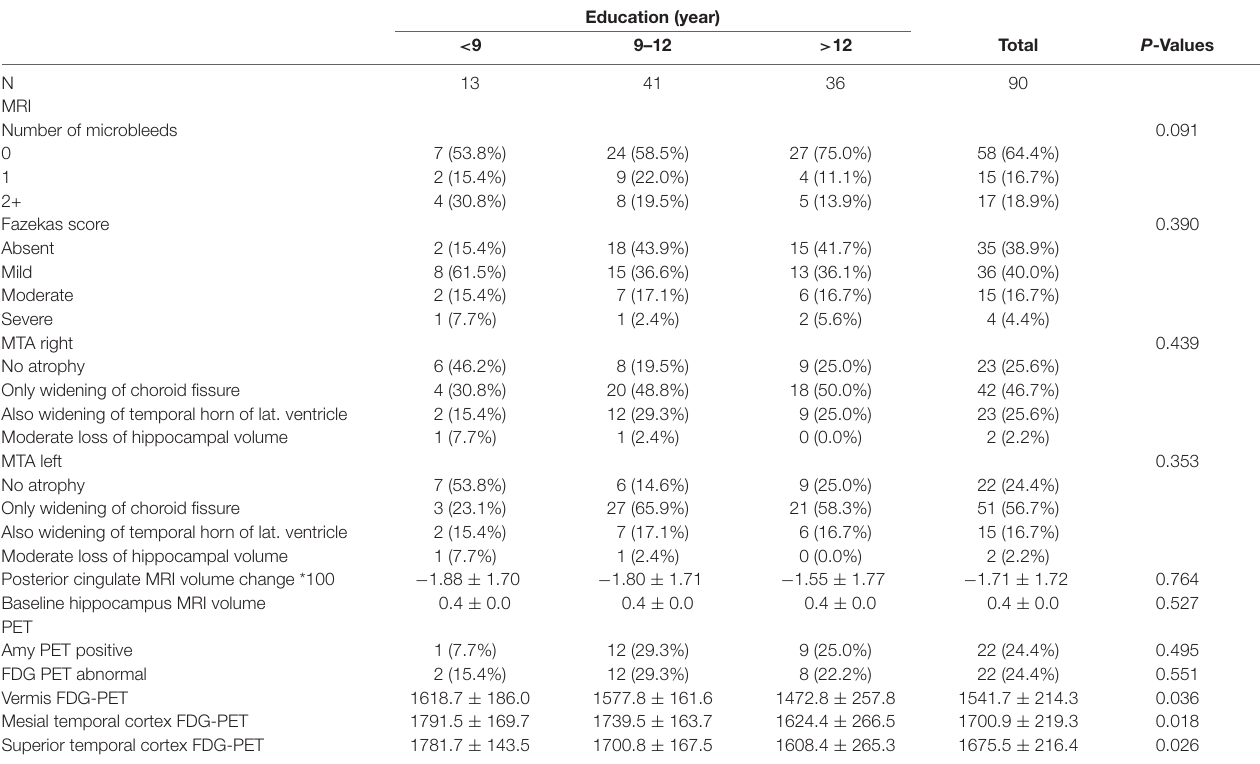
TABLE 1 | Demographic, clinical, and imaging data by education attainment level in the present